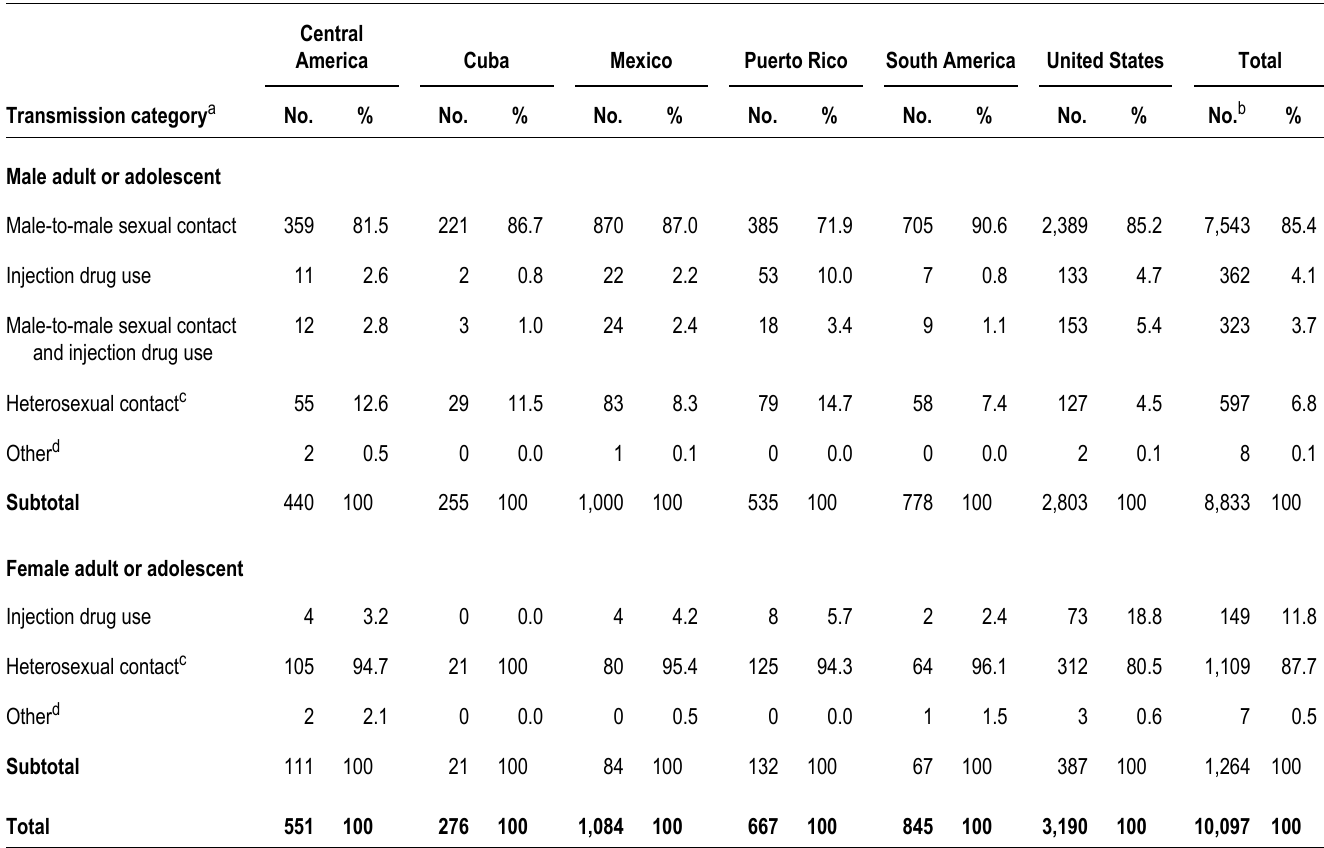
Table 16. Diagnoses of HIV infection among adult and adolescent Hispanics/Latinos, by transmission category and place of birth, 2018—United States and 6 dependent areas Central America Cuba Mexico Puerto Rico South America